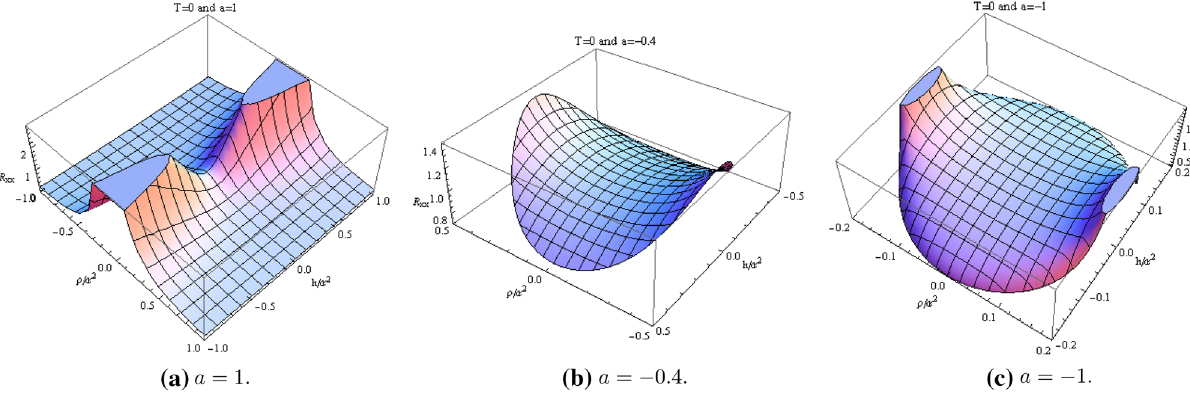
Fig. 6 Plots of R xx versus ρ/α 2 and h /α 2 with a = 1, a = − 0 . 4 and a = − 1 at T = 0 for Born-Infeld